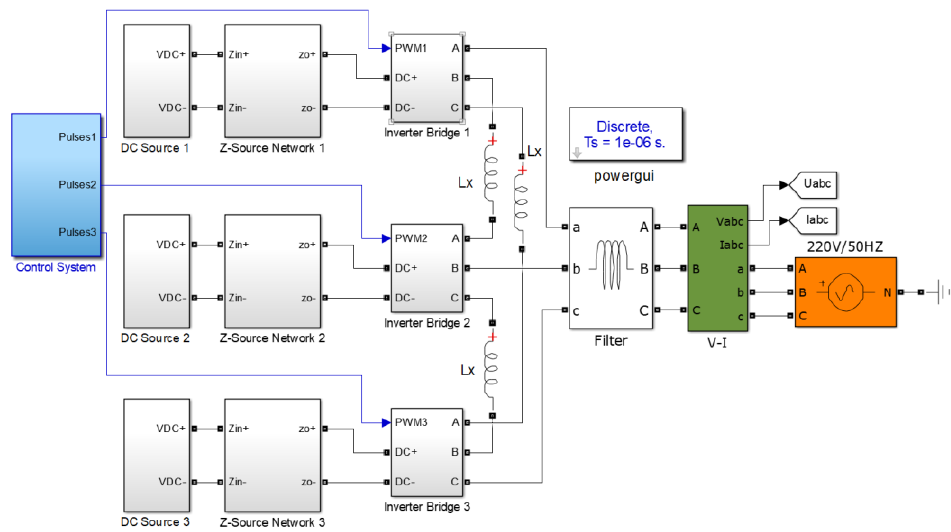
Figure 5. LVC-qZSI circuit system.